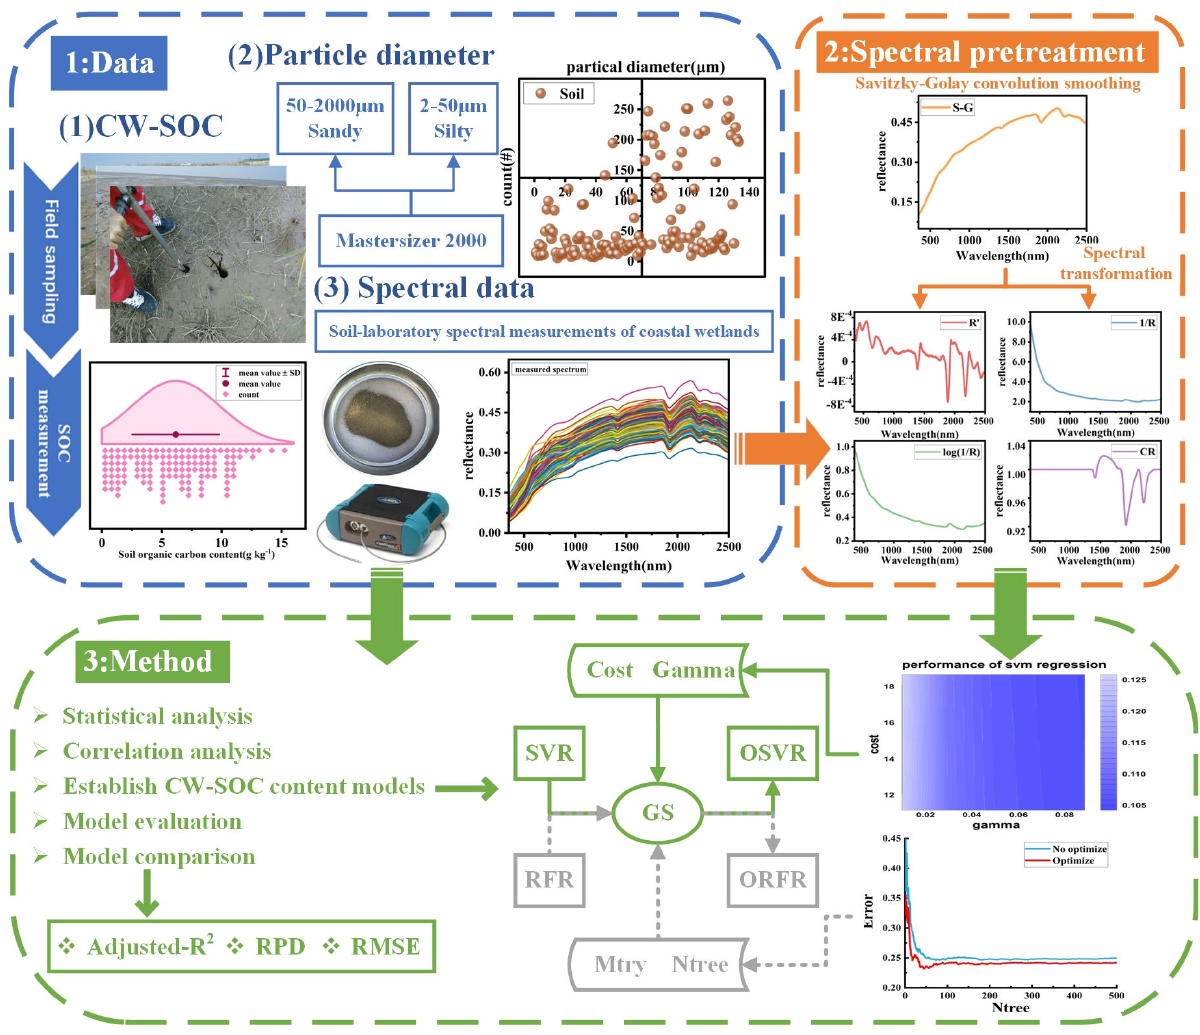
Figure 3. The framework of this study.